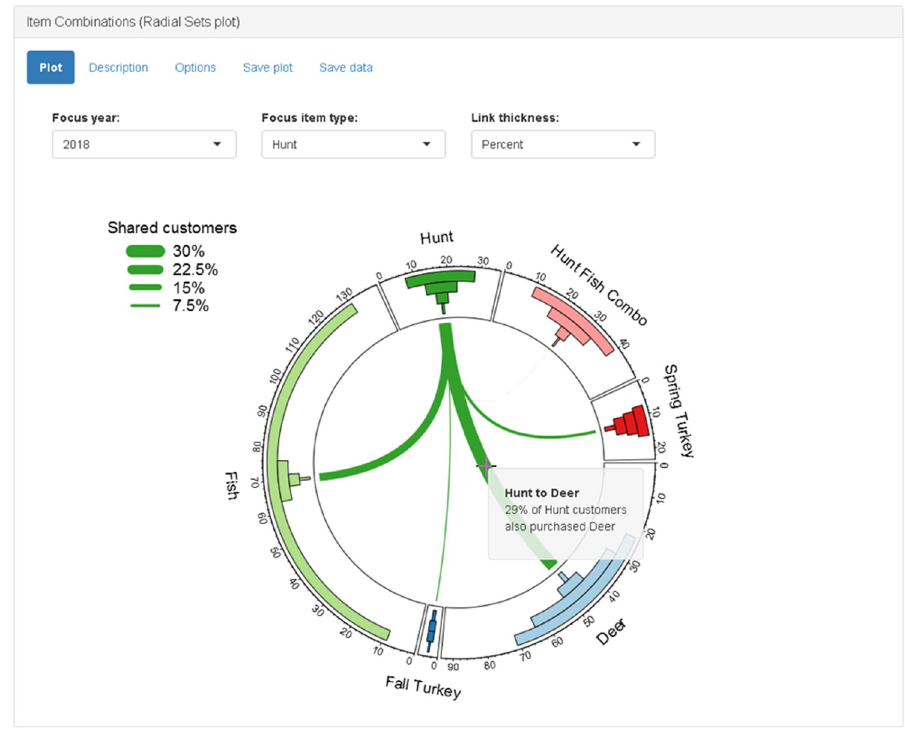
Fig 10. Screenshot of item combinations (Radial Sets plot) panel when “hunt” is selected as focus item type.